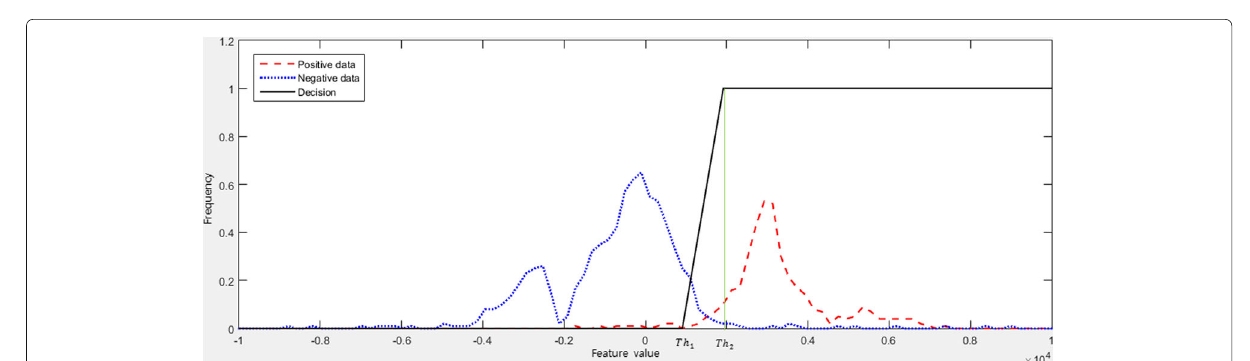
Fig. 8 Data distribution and thresholds along feature value F ∗